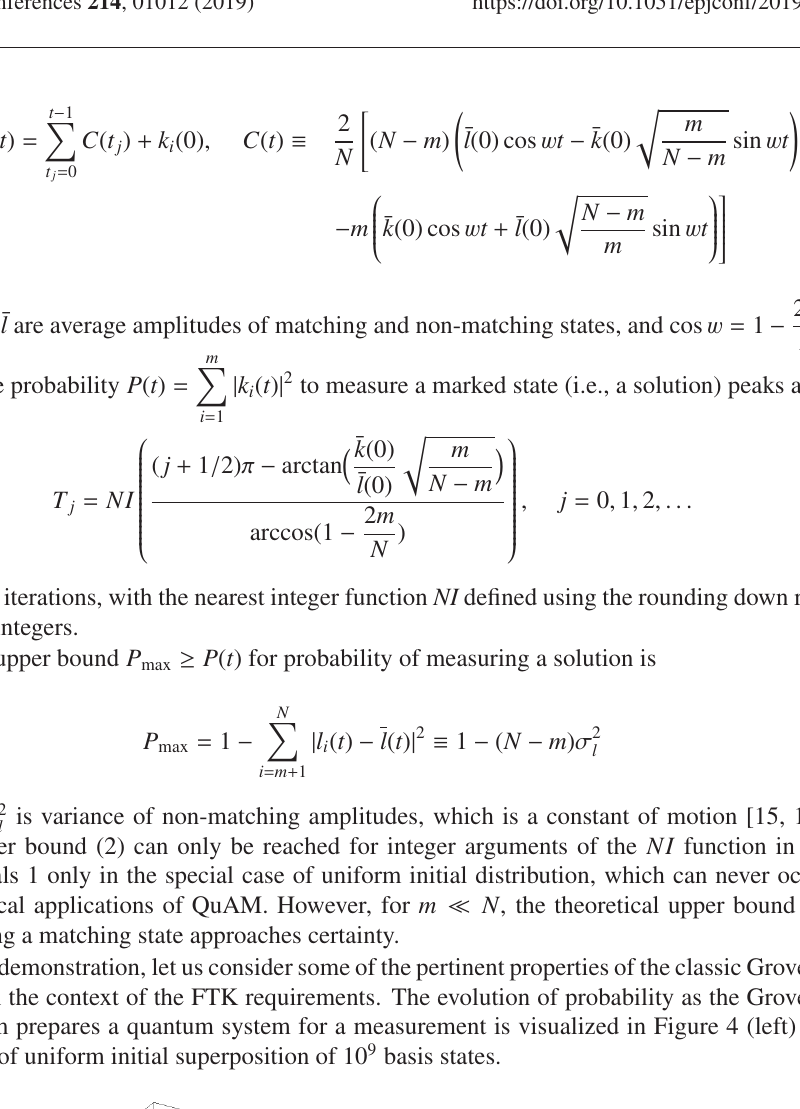
Figure 3: The quantum circuit implementing a variant of the Grover’s algorithm general-